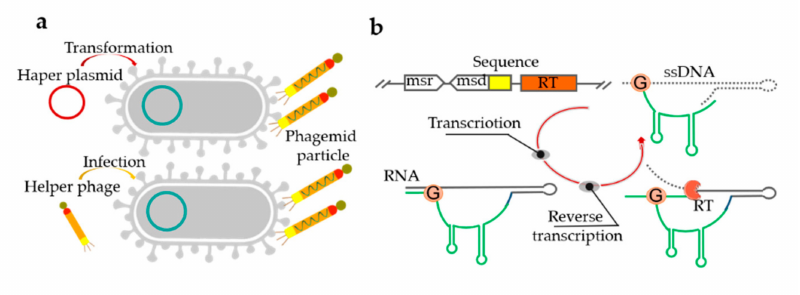
Figure 4. Bacteria-based ssDNA synthesis. ( a ) Schematic of the two approaches to phagemid-based ssDNA production. The phagemid-carrying E. coli cells are infected with the “helper phage” or transformed with a “helper plasmid”, the ssDNA can be generated. ( b ) The processes of ssDNA production by bacterial reverse transcriptases (RTs). In transcription step, the msr-msd RNA folds into a secondary structure; In reverse transcription step, the RT recognizes this secondary structure and